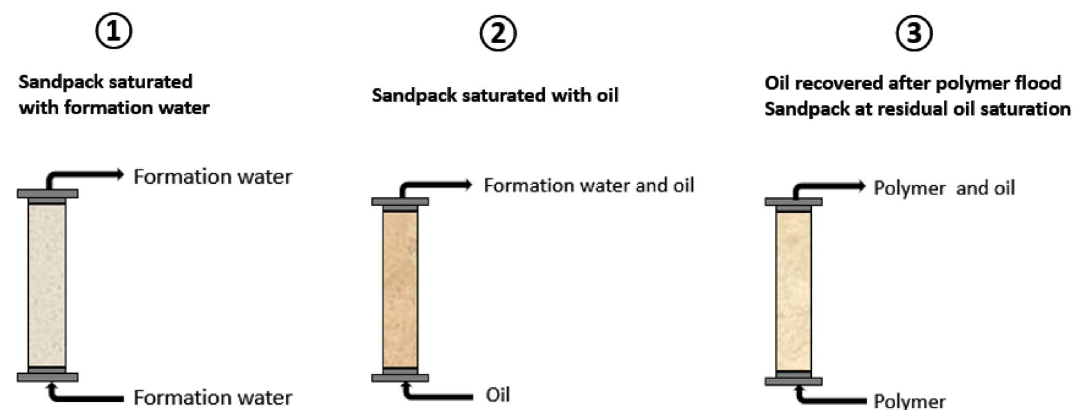
Fig. 7 Schematic of experimental flood procedure